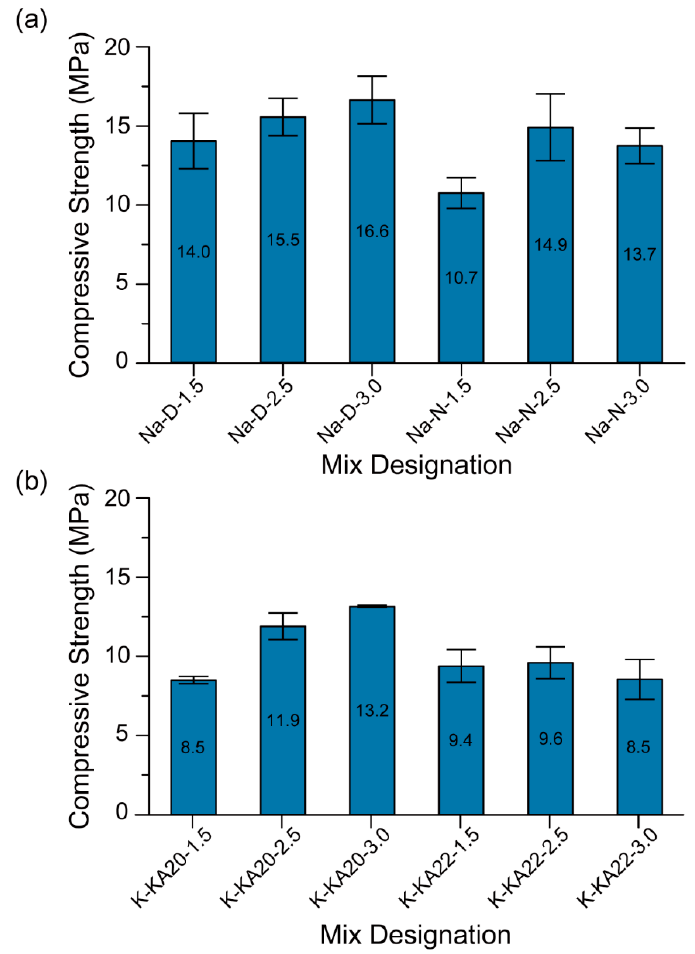
Figure 10. Compressive strength of 3D printed geopolymers with ( a ) Na-based activators and ( b ) K-based activators.